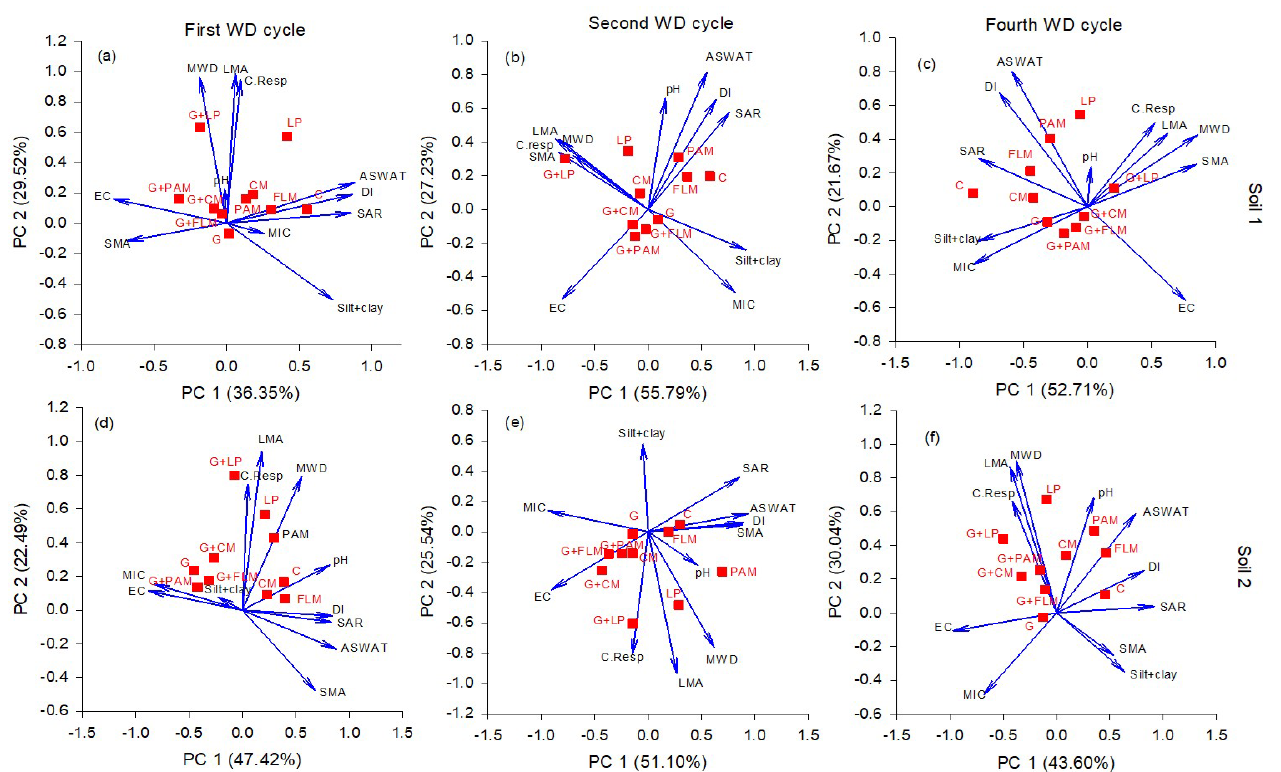
Figure 5. Principal component analysis (PCA) biplot of the physico-chemical and microbial properties effected by different treatments in two soils after first, second, and fourth WD cycle: Soil 1 (a, b, c) and Soil 2 (d, e, f) . The treatments are C: control, G: gypsum, PAM: anionic polyacrylamide, FLM: feedlot manure, CM: chicken manure, and LP: lucerne pellets. The data presented in these PCA biplots are the mean data of all the days for each parameter (blue arrows) and factorial scores of all the treatments (red squares). The parameters are ASWAT scores (aggregate stability in water test), DI (dispersion index), C. Resp (cumulative microbial respiration), SAR (sodium adsorption ratio), EC (electrical conductivity 1 : 5), LMA (large macroaggregates), SMA (small macroaggregates), MIC (microaggregates), silt + clay, and MWD (mean weight